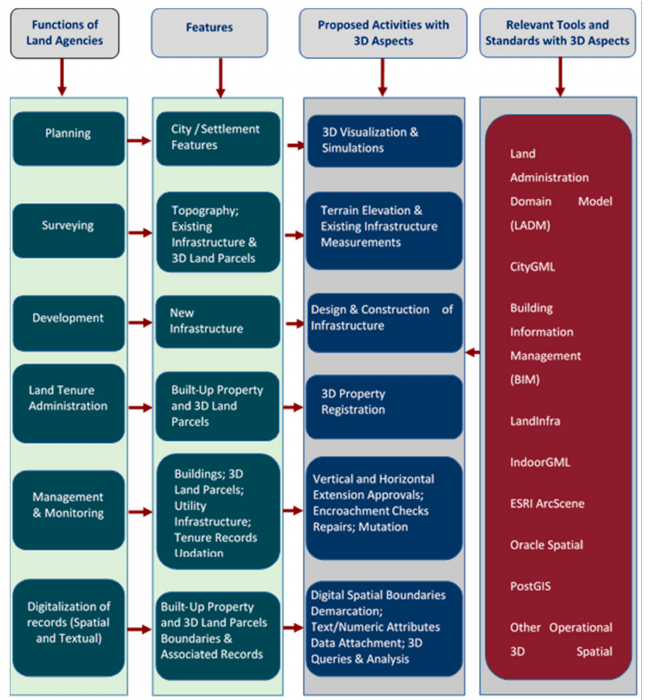
Figure 6. The proposed activities with 3D aspects for a land administration system in a modern